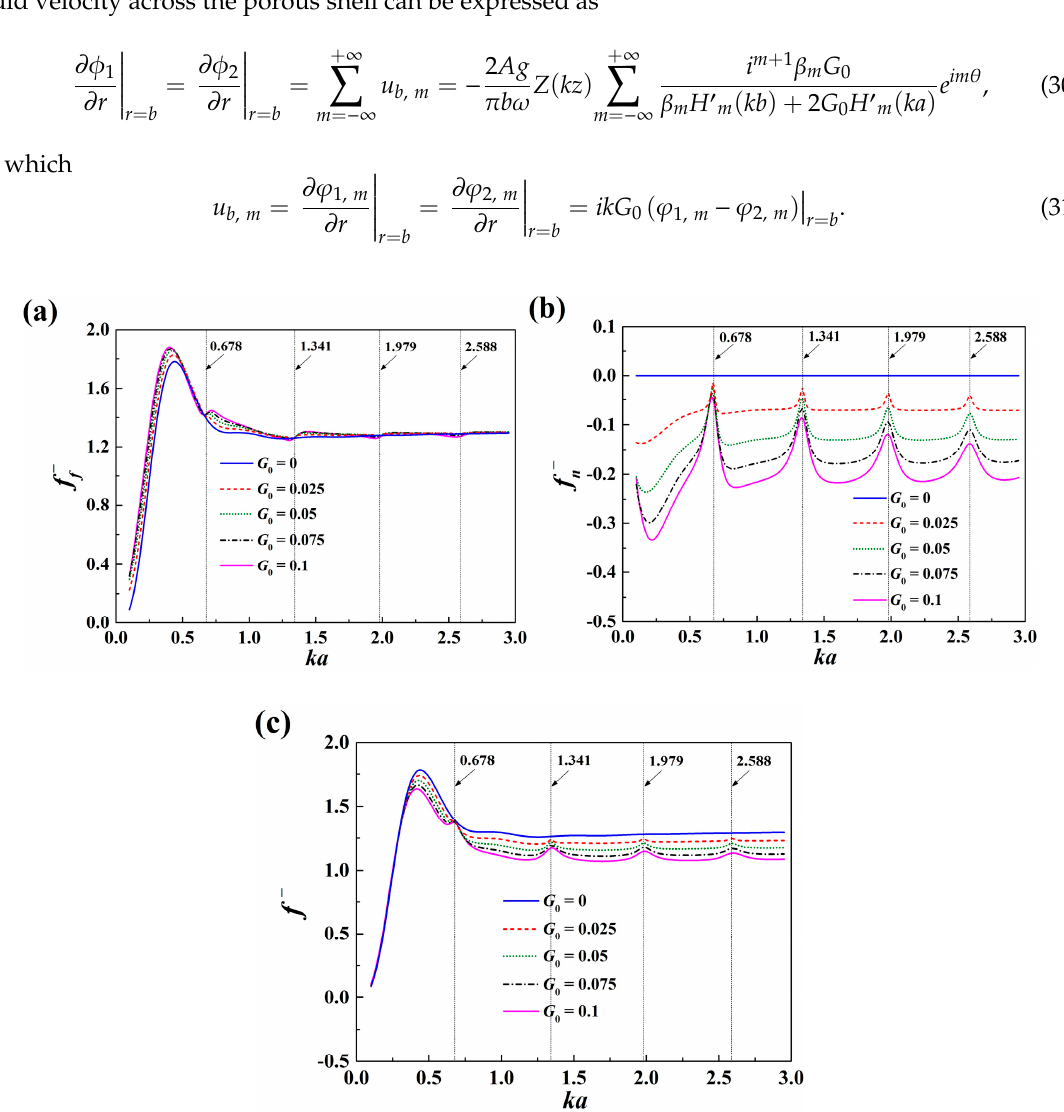
Figure 2. Effect of the porous parameter G 0 on the force components and the total mean drift wave force on the system using a far-field formulation ( b = 2 a and d = 3 a ): ( a ) f −